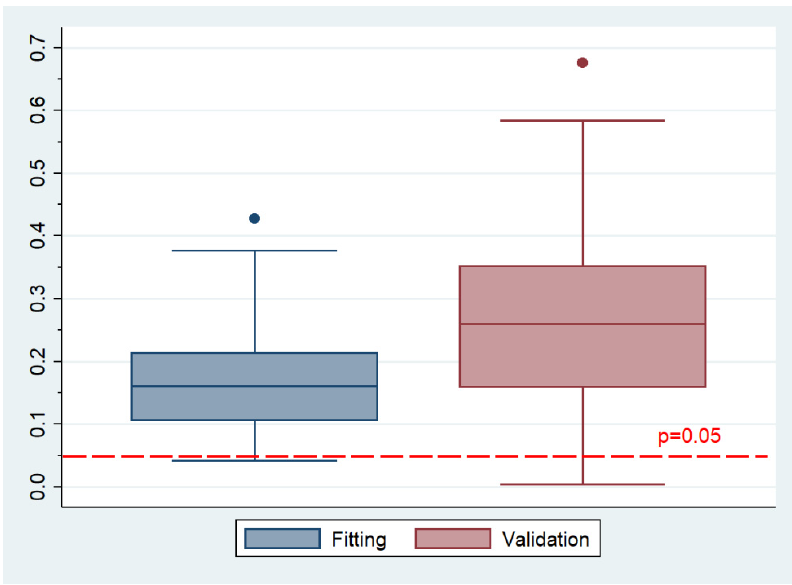
Figure 1. Pearson’s χ 2 —fitting vs. validation model distributions (households).